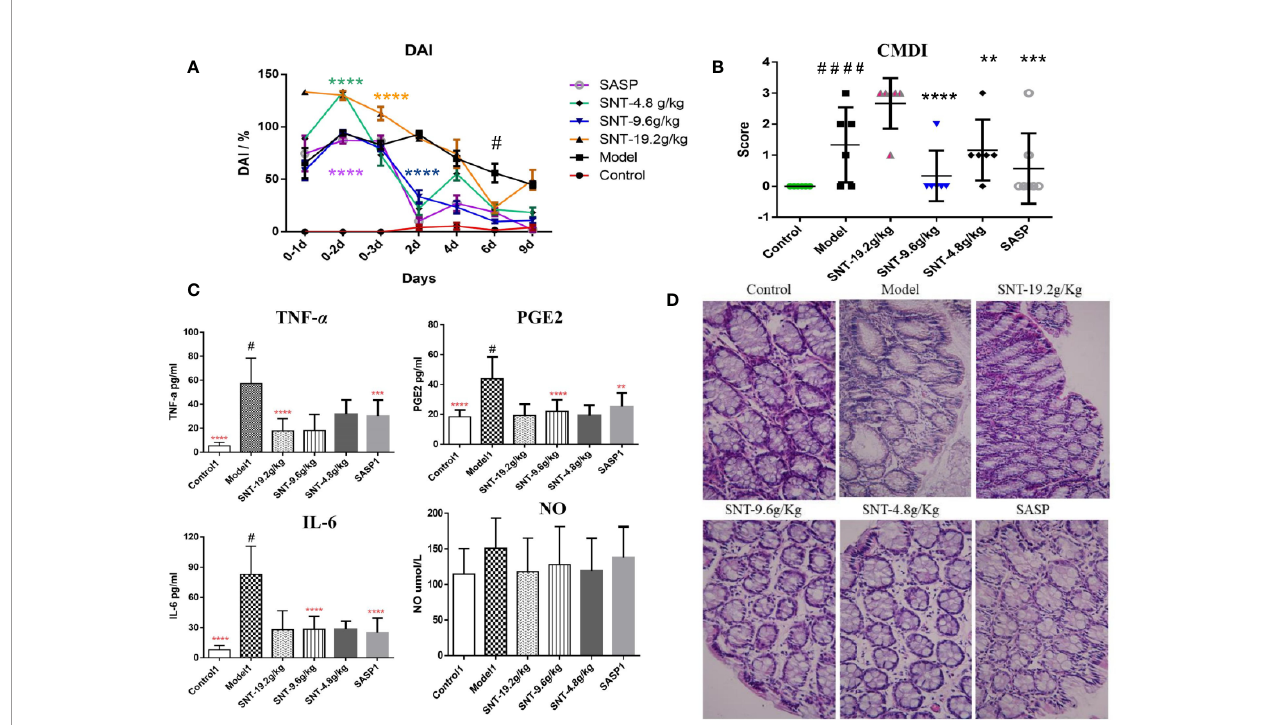
FIGURE 2 | Assessment of the ef fi cacy of SNT against UC in rats with TNBS-induced UC. (A) Disease activity index (DAI) in rats in each group (DAI was assessed on the day of the TNBS administration and the next two days (days 0 – 3, 0 – 2, and 0 – 1, where day 0 – 1 is the fi rst day of TNBS administration) and during treatment administration (days 2, 4, 6, and 9 after treatment began). (B) Colon mucosal damage index (CMDI) in rats in each group, evaluated after 9 days of treatment administration. (C) Enzyme- linked immunosorbent assays (ELISAs) of serum cytokine levels in rats in each group. (D) Hematoxylin and eosin (HE) staining showing the degree of intestinal mucosal injury in rats in each group (×40), ** P < 0.01, *** P < 0.001, **** P < 0.0001 vs UC model group; # P < 0.05, #### P < 0.0001 vs normal control